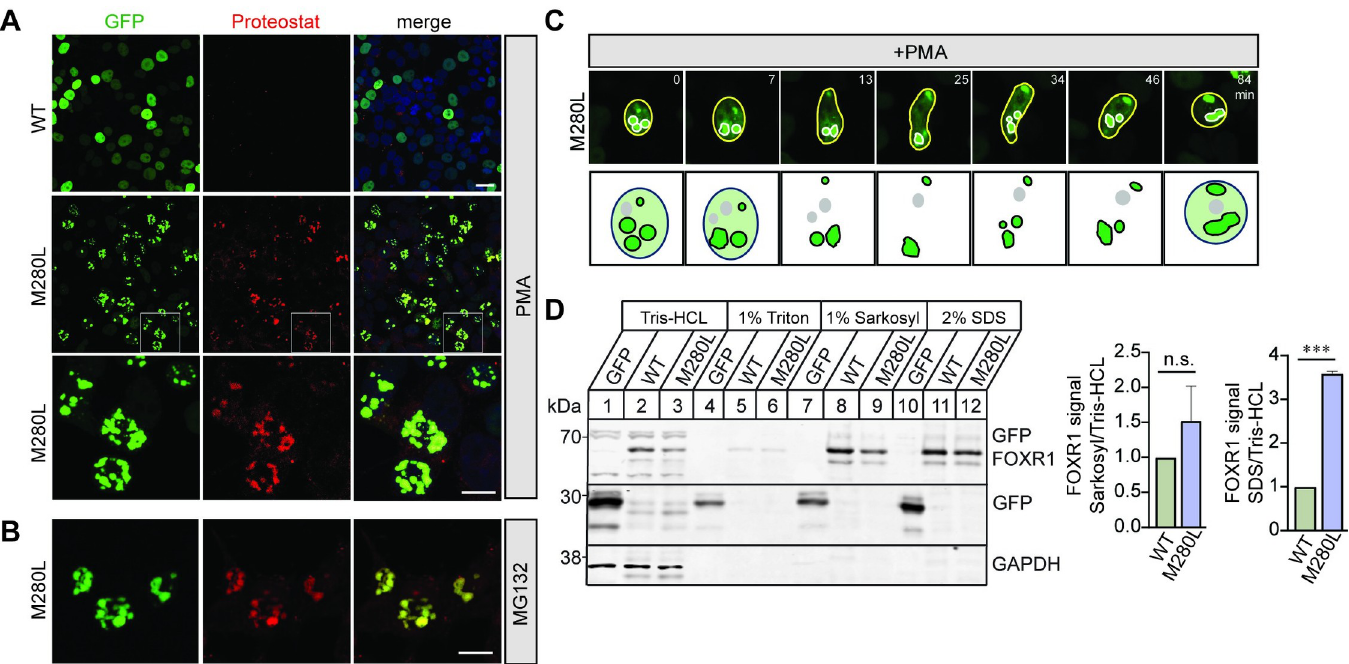
Fig 7. M280L nuclear aggregates are insoluble misfolded proteins. (A) Fluorescence images of HEK293T cells transfected with GFP-tagged human FOXR1 WT or M280L and treated with PMA. Cells were fixed after 24 hours of treatment and immunolabeled with Proteostat marker. White square box in the middle panels indicate images presented in the bottom panel at higher magnification. Top and middle panels, scale bar = 20 μ m. Bottom panels, scale bar = 10 μ m. (B) Fluorescence images of HEK293T cells transfected with GFP-tagged M280L and treated with MG132. Cells were fixed after 24 hours of treatment and immunolabeled with Proteostat marker. Scale bar = 10 μ m. (C) Time-lapse imaging of HEK293T cells transfected with GFP-tagged M280L. Top panel represents images showing nuclear aggregates undergoing extensive movements and fusions. Bottom panel illustrates schematic drawings of the fusion events. Scale bar = 5 μ m. (D) FOXR1 was sequentially extracted with Tris- HCl, Triton X-100, Sarkosyl and SDS. Quantification shows that the amount of FOXR1 in the sarkosyl fraction was not significant (n.s.) between WT and M280L. However, the SDS fraction was significantly higher in the M280L mutant when compared to the overall Tris-HCl total fraction. One-way ANOVA Tukey’s multiple comparisons (n = 2 independent experiments, ��� p =